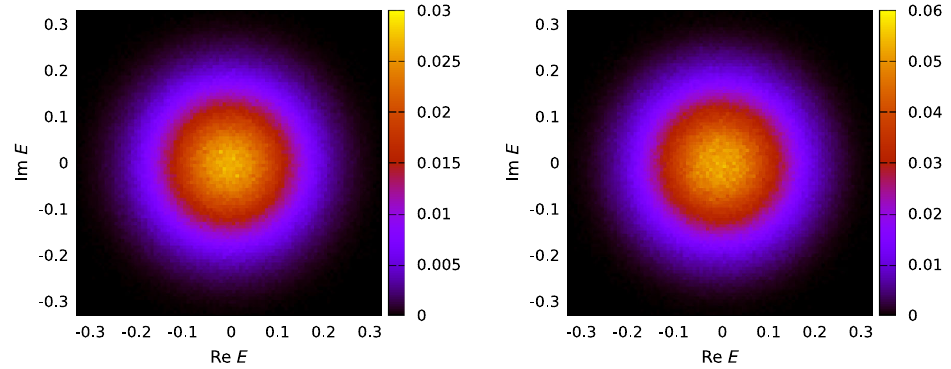
FIG. 1. Spectral density associated with the complex eigenvalues of the nHSYK Hamiltonian of Eq. (1) for q ¼ 2 and N ¼ 18 (left panel) and 20 (right panel). The spectral density is radially symmetric, and it has a maximum in the j E j ∼ 0 region and then decreases monotonically with no sign of a sharp spectral edge. There is no qualitative dependence on N . We see that the level correlations are not quantum chaotic.